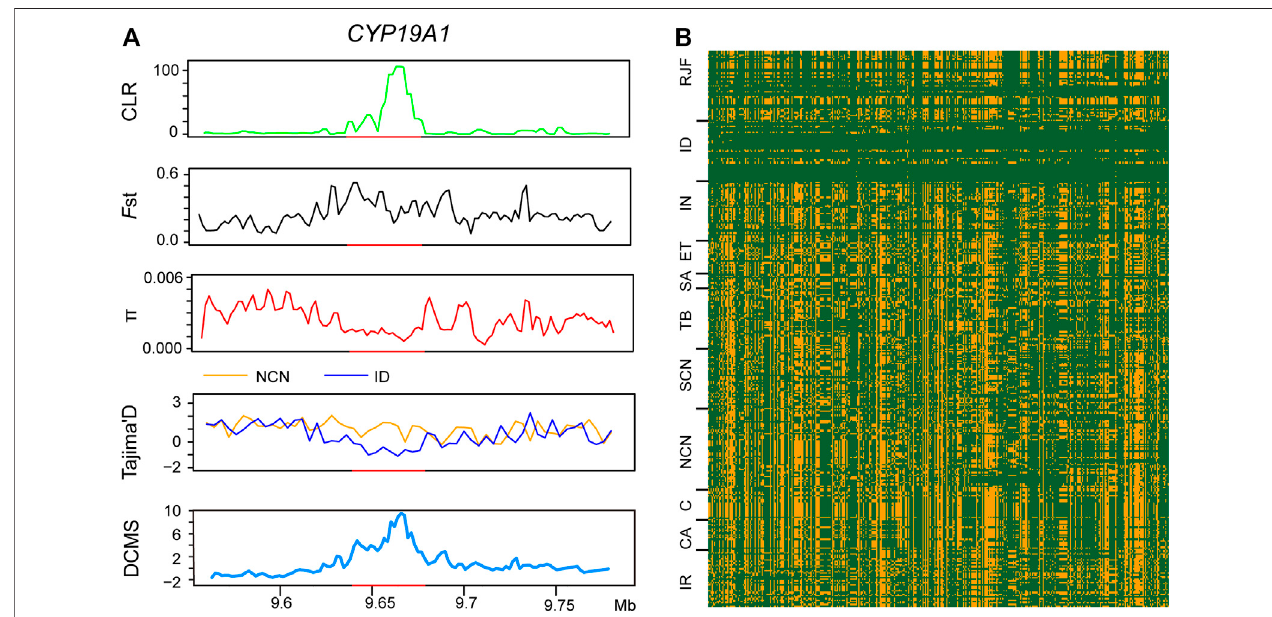
FIGURE 3 | Selective signatures and haplotype analysis in CYP19A1 gene identi fi ed by Indonesian chickens. (A) the CYP19A1 gene is additionally validated by CLR, F st, π , Tajima ’ s D, and DCMS. (B) haplotype analysis at the CYP19A1 gene. Gallus gallus spadiceus from China and Thailand (RJF), Chantecler chickens (CA), Tibetan chicken (TB), chickens of southern China (SCN), commercial chickens (C), Iranian chickens (IR), and Ethiopian chickens